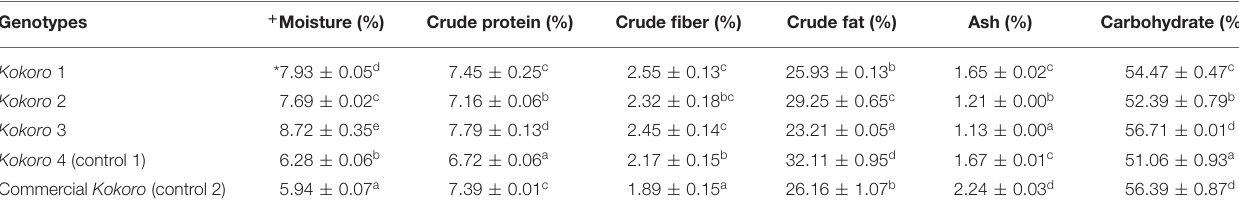
TABLE 2 | Chemical composition of Kokoro from provitamin A maize genotypes, yellow maize and commercially purchased Kokoro .